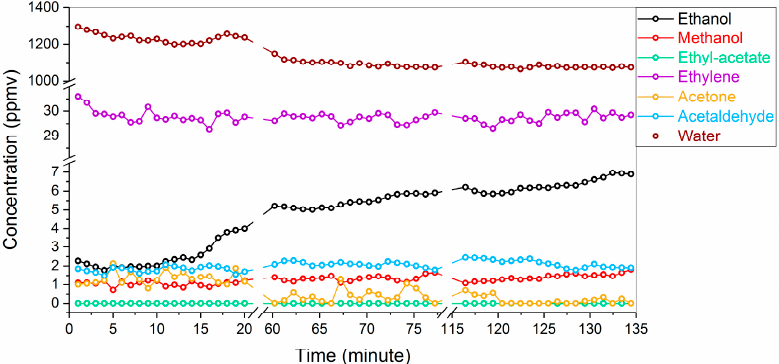
Figure 7. Time-dependent representation of the obtained concentration values of multiple gas species based on the same pear-storage container. The breaking of the time axis is due to an alternating operation configuration to measure two different storage containers. For clarity purposes, the data of the other container are not shown.